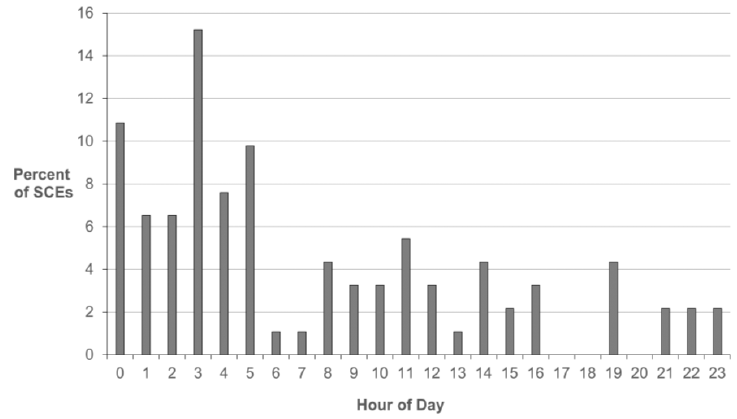
Figure 3. Percent of safety-critical events (SCEs) by hour of day.